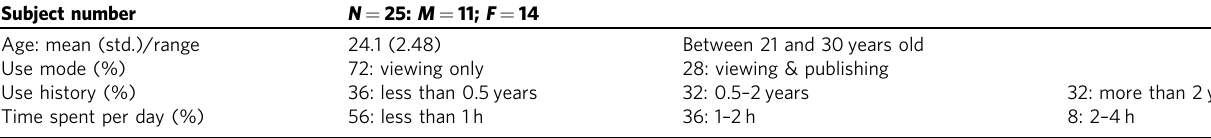
mPFC at the level of the anterior horns of the corpus callosum. We counted cells in sections corresponding to the tip of the optic fi ber and 1 to 2 sections